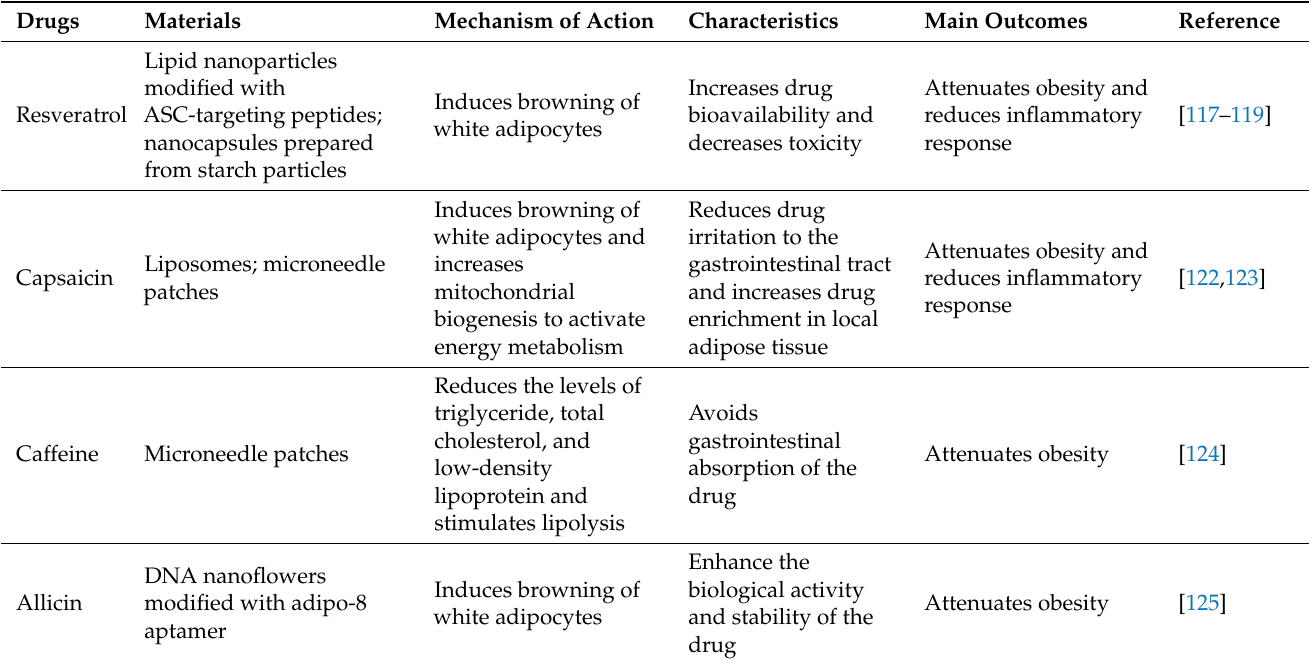
Table 3. Biomaterial-encapsulated phytochemicals for anti-obesity